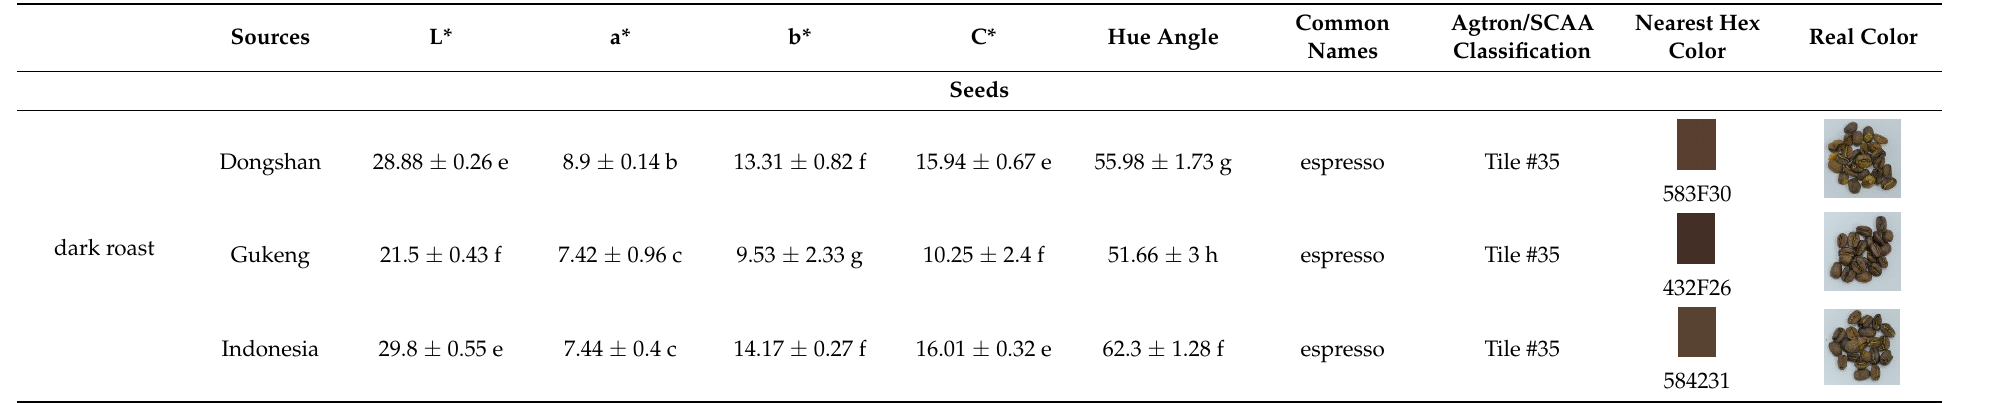
Table 2. CIE L*, a*, and b* values of different sources and roasting degrees of ground coffee. Sources